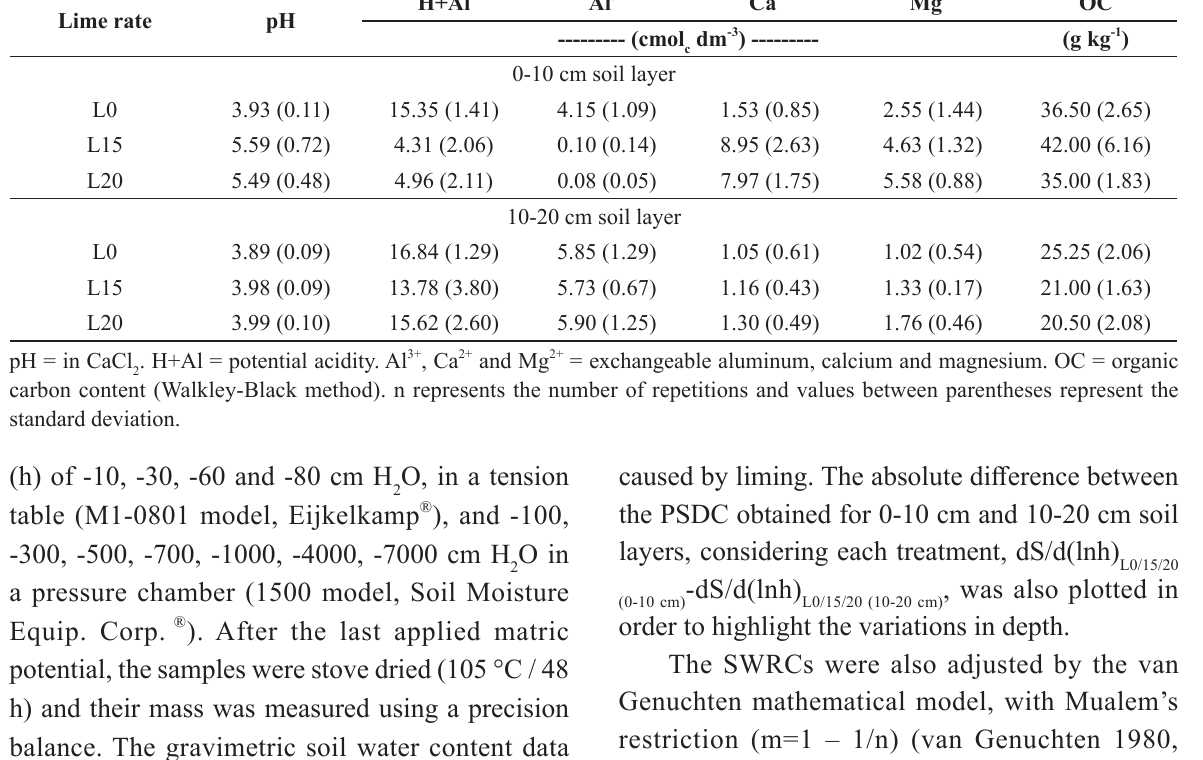
Chemical attributes for 0-10 cm and 10-20 cm soil layers (n=4). Lime